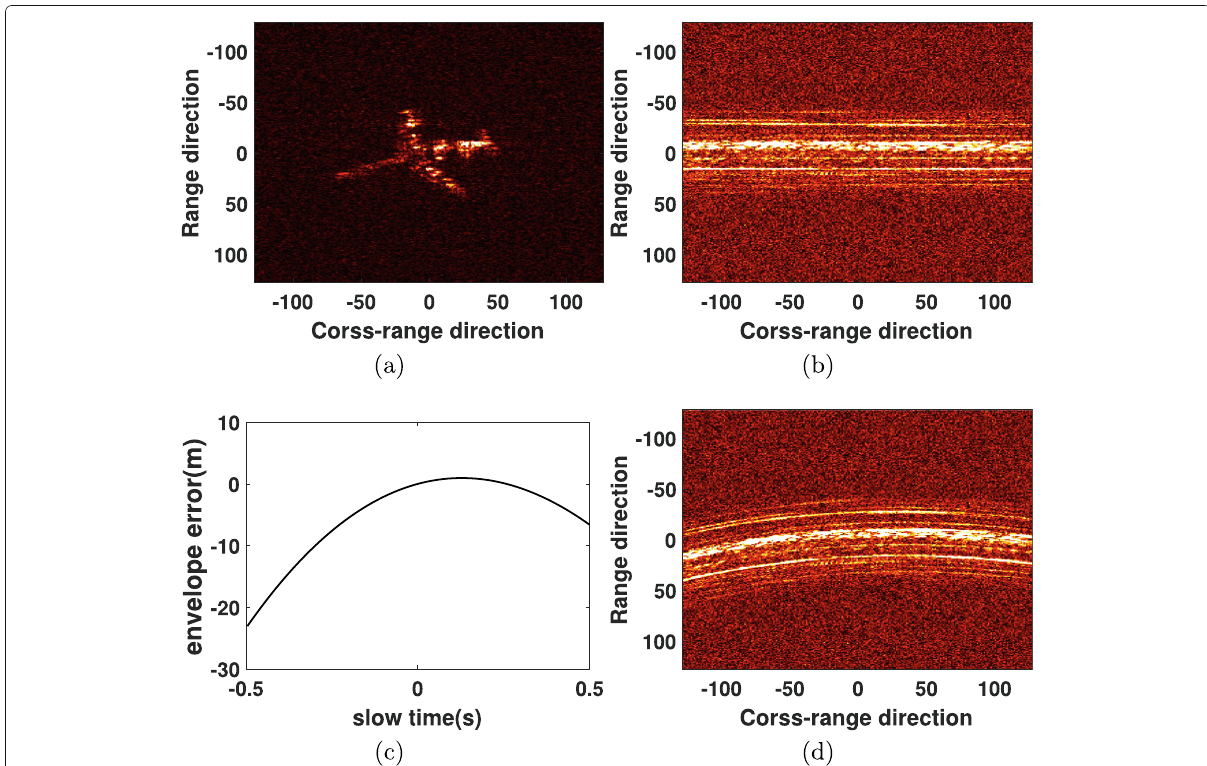
Fig. 9 Adding the envelope deviation errors. a The original ISAR image, b the original range profiles, c the three-order error, and d the contaminated range